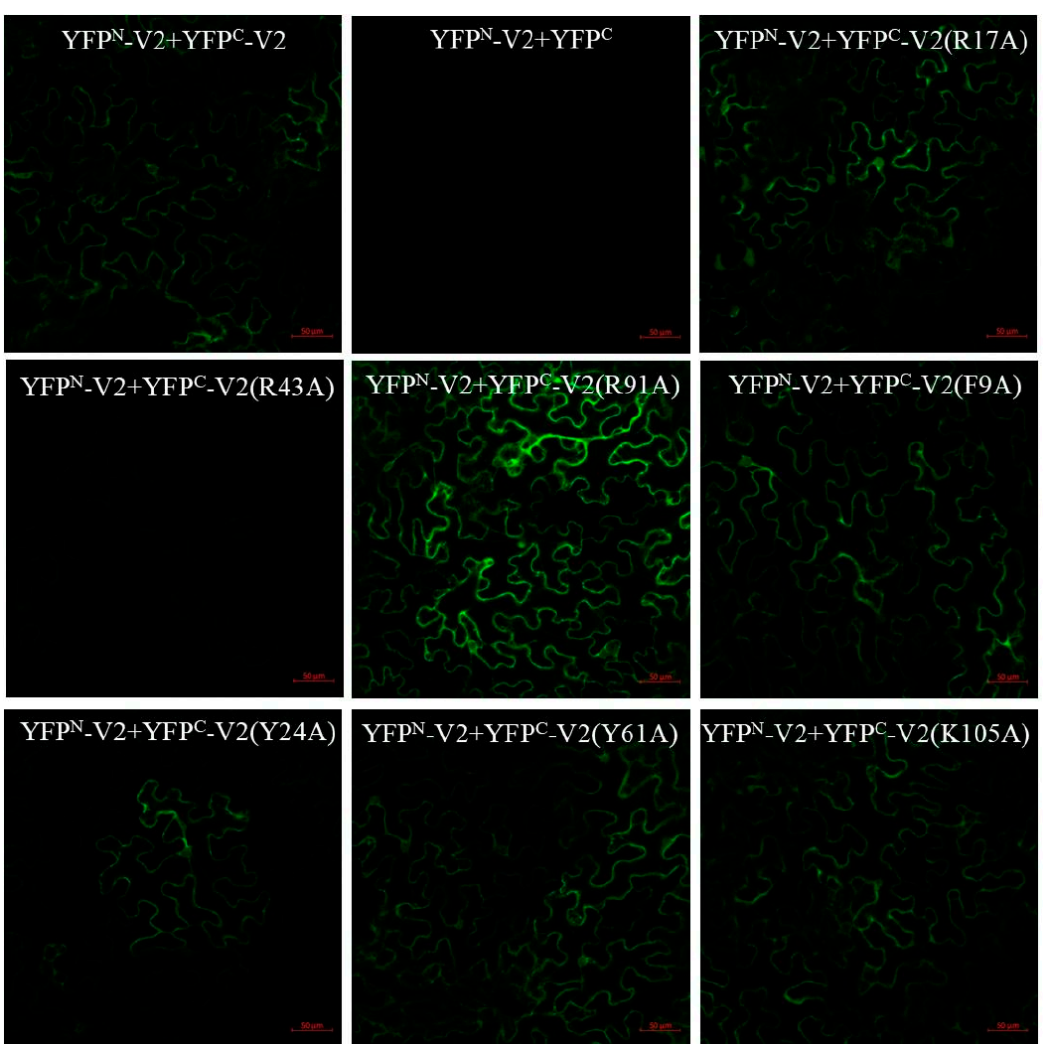
Figure 5. Effects of amino acid substitutions on V2 self-interaction. Bimolecular fluorescence complementation (BiFC) analyses of the interaction between wt V2 and V2 mutants in N. benthamiana . Different BiFC vector combinations were co-agroinfiltrated into N. benthamiana leaves, respectively, and YFP fluorescence were detected at 3 days post-agroinfiltration (dpa) at wavelength of 488 nm. Bars = 50 µ